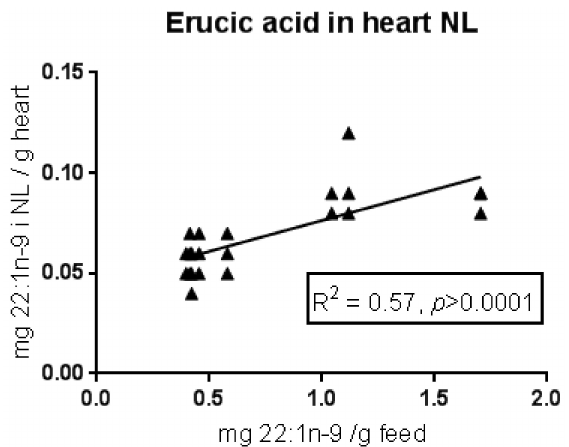
Figure 4. Content of erucic acid (22:1n-9) in neutral lipids (NL) of the heart in Atlantic salmon, in relation to the dietary content of erucic acid. The data are from a feeding trial [10] where salmon were given eight experimental feeds ranging from 40–170 mg erucic acid/100 g feed. The adjusted R -value and the p -value for a linear regression model are given.